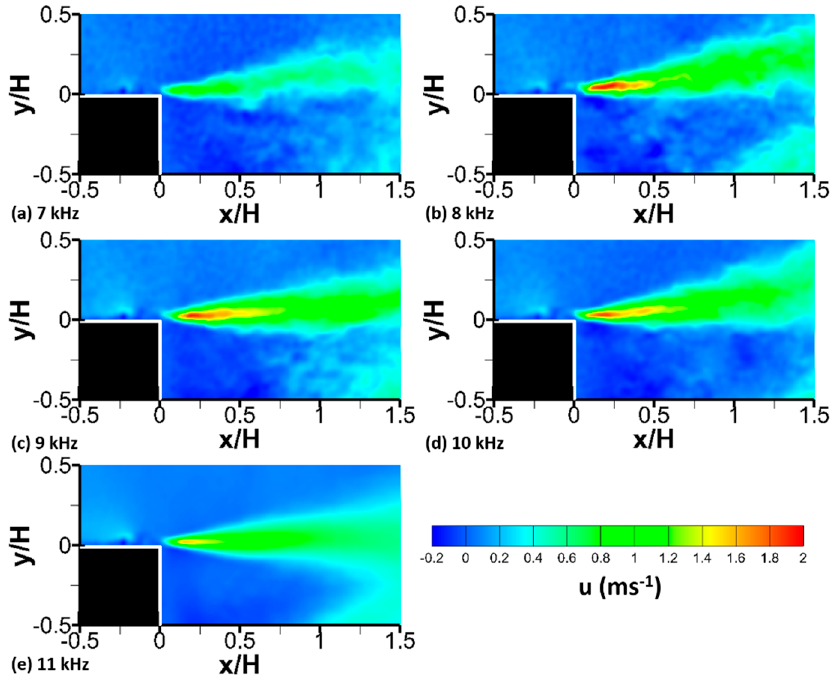
Figure 6. Jet velocity in the x-direction generated by the plasma actuator at various actuation frequencies. ( a ) 7 kHz, ( b ) 8 kHz, ( c ) 9 kHz, ( d ) 10 kHz, and ( e ) 11 kHz.